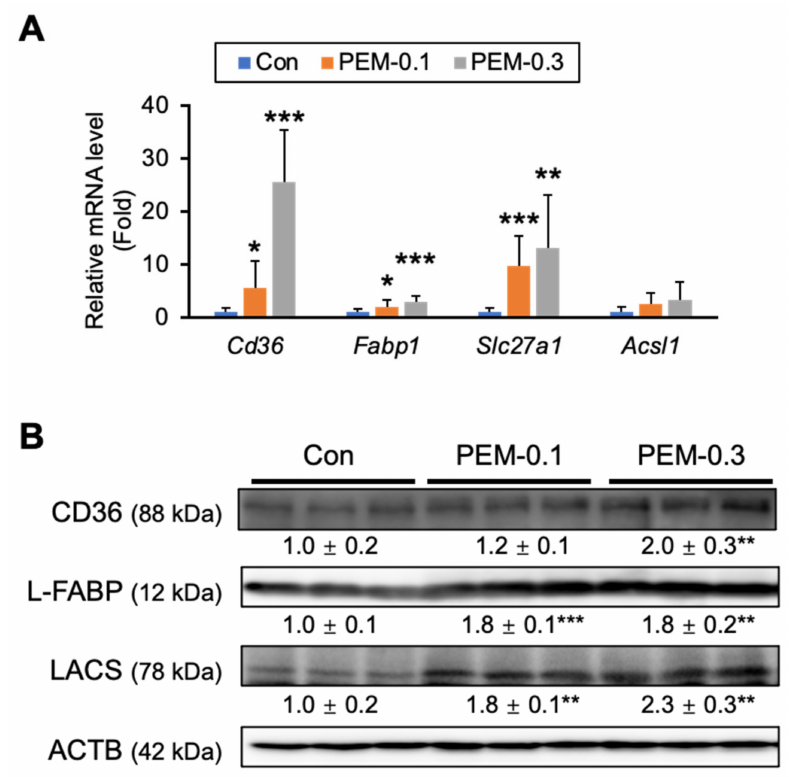
Figure 3. Clinically relevant dose of PEM significantly increases FA uptake in the liver. ( A ) Hepatic mRNA levels of Cd36 , Fabp1 , Slc27a1 , and Acsl1 were quantified by qPCR, normalized to that of 18s ribosomal RNA, and expressed as values relative to those of control mice. ( B ) Immunoblot analysis of CD36, L-FABP, and LACS. ACTB was used as a loading control. Band intensity was measured densitometrically, normalized to that of ACTB, and expressed as values relative to those of control mice. Results were obtained from two independent immunoblot experiments. Data are expressed as the mean ± SD. * p < 0.05, ** p < 0.01, and *** p < 0.001 vs. control group. Con, vehicle-treated mice; PEM-0.1, pemafibrate-treated mice at a clinically relevant dose (0.1 mg/kg/day); PEM-0.3, pemafibrate-treated mice at a relatively high dose (0.3